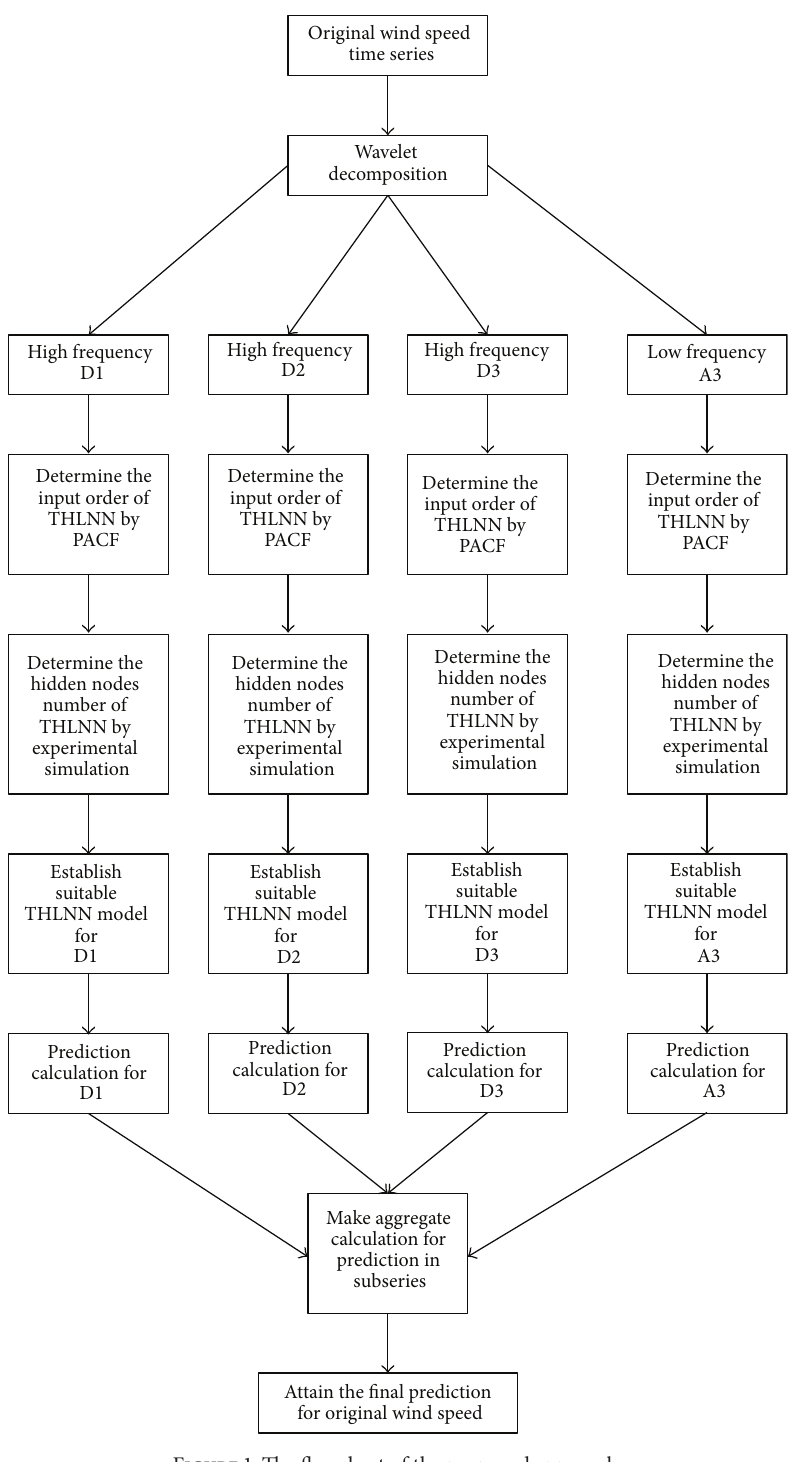
Figure 1: The flowchart of the proposed